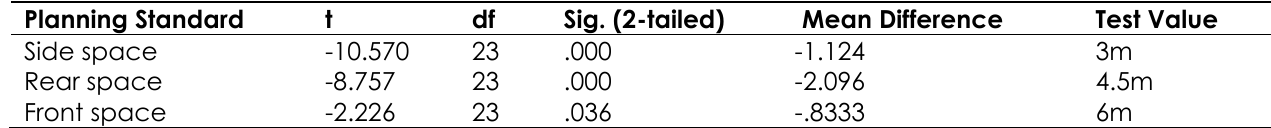
Table 2: One-test for observed compliance in